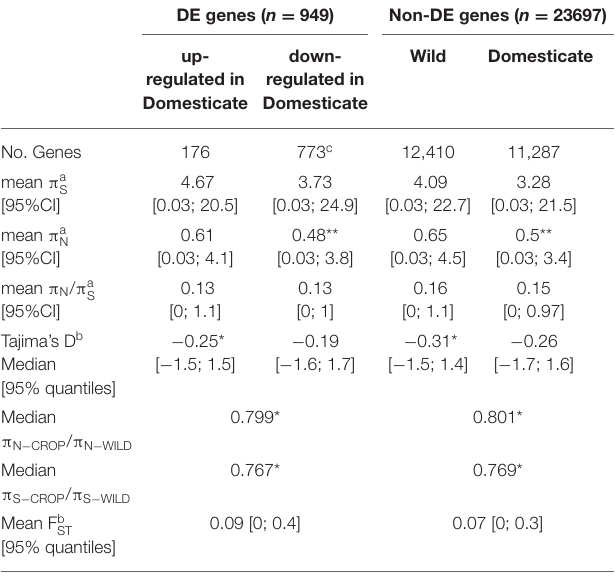
TABLE 3 | Comparison of polymorphism patterns between genes significantly differentially expressed (DE) at 1% FDR and non-differentially expressed genes (non-DE) between wild and domesticated Sorghum bicolor